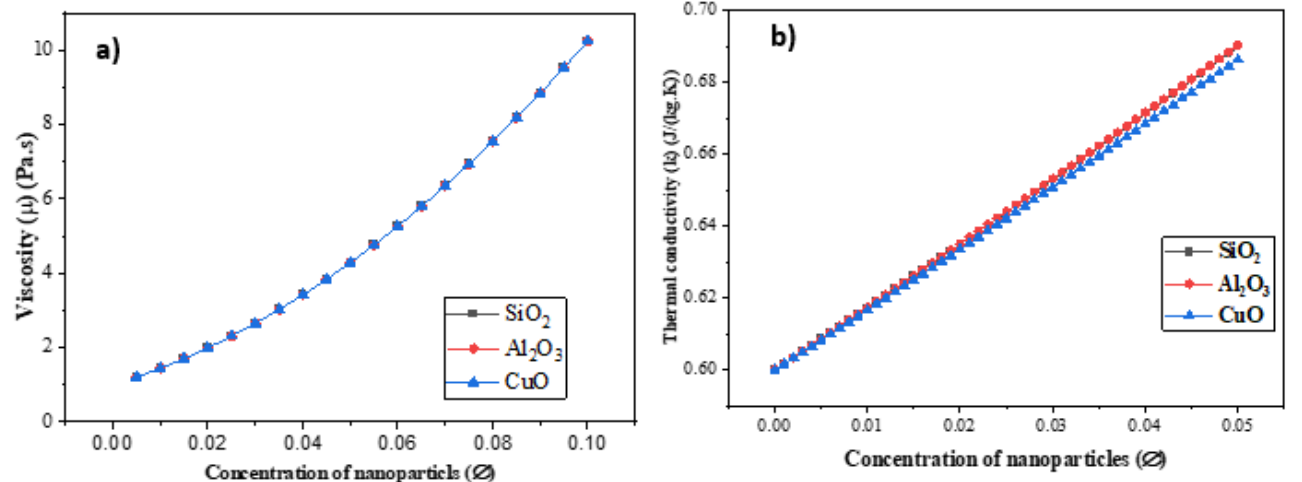
Figure 5. ( a ) Influence of nanoparticles on viscosity and ( b ) effect of nanoparticles on thermal conductivity. Table 8. Total characteristics that may be used in the energy equation.